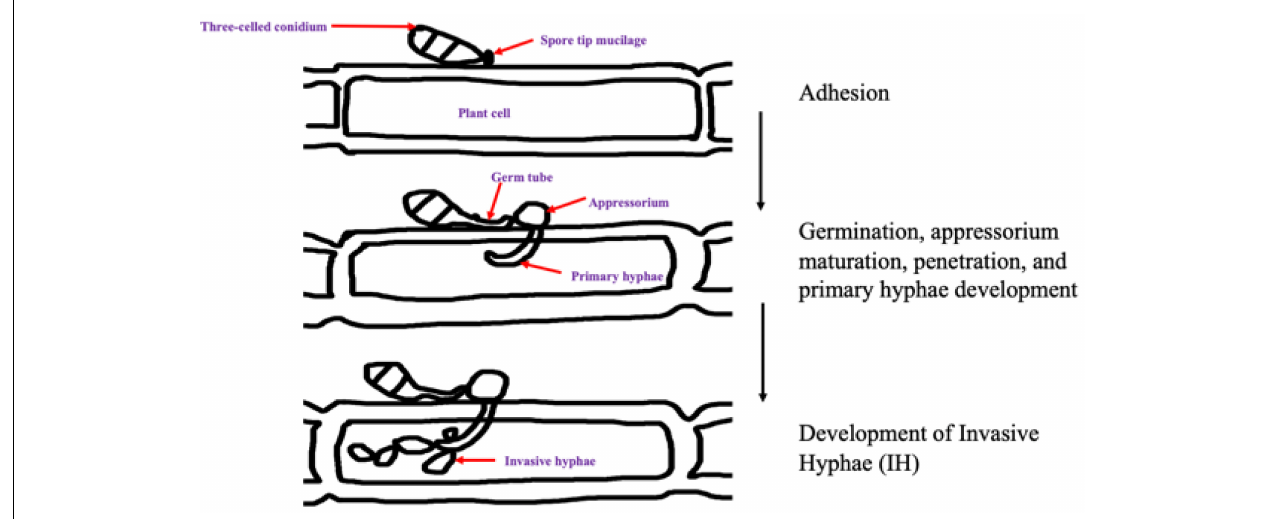
FIGURE 2 | A schematic representation of the infection cycle of M. oryzae .